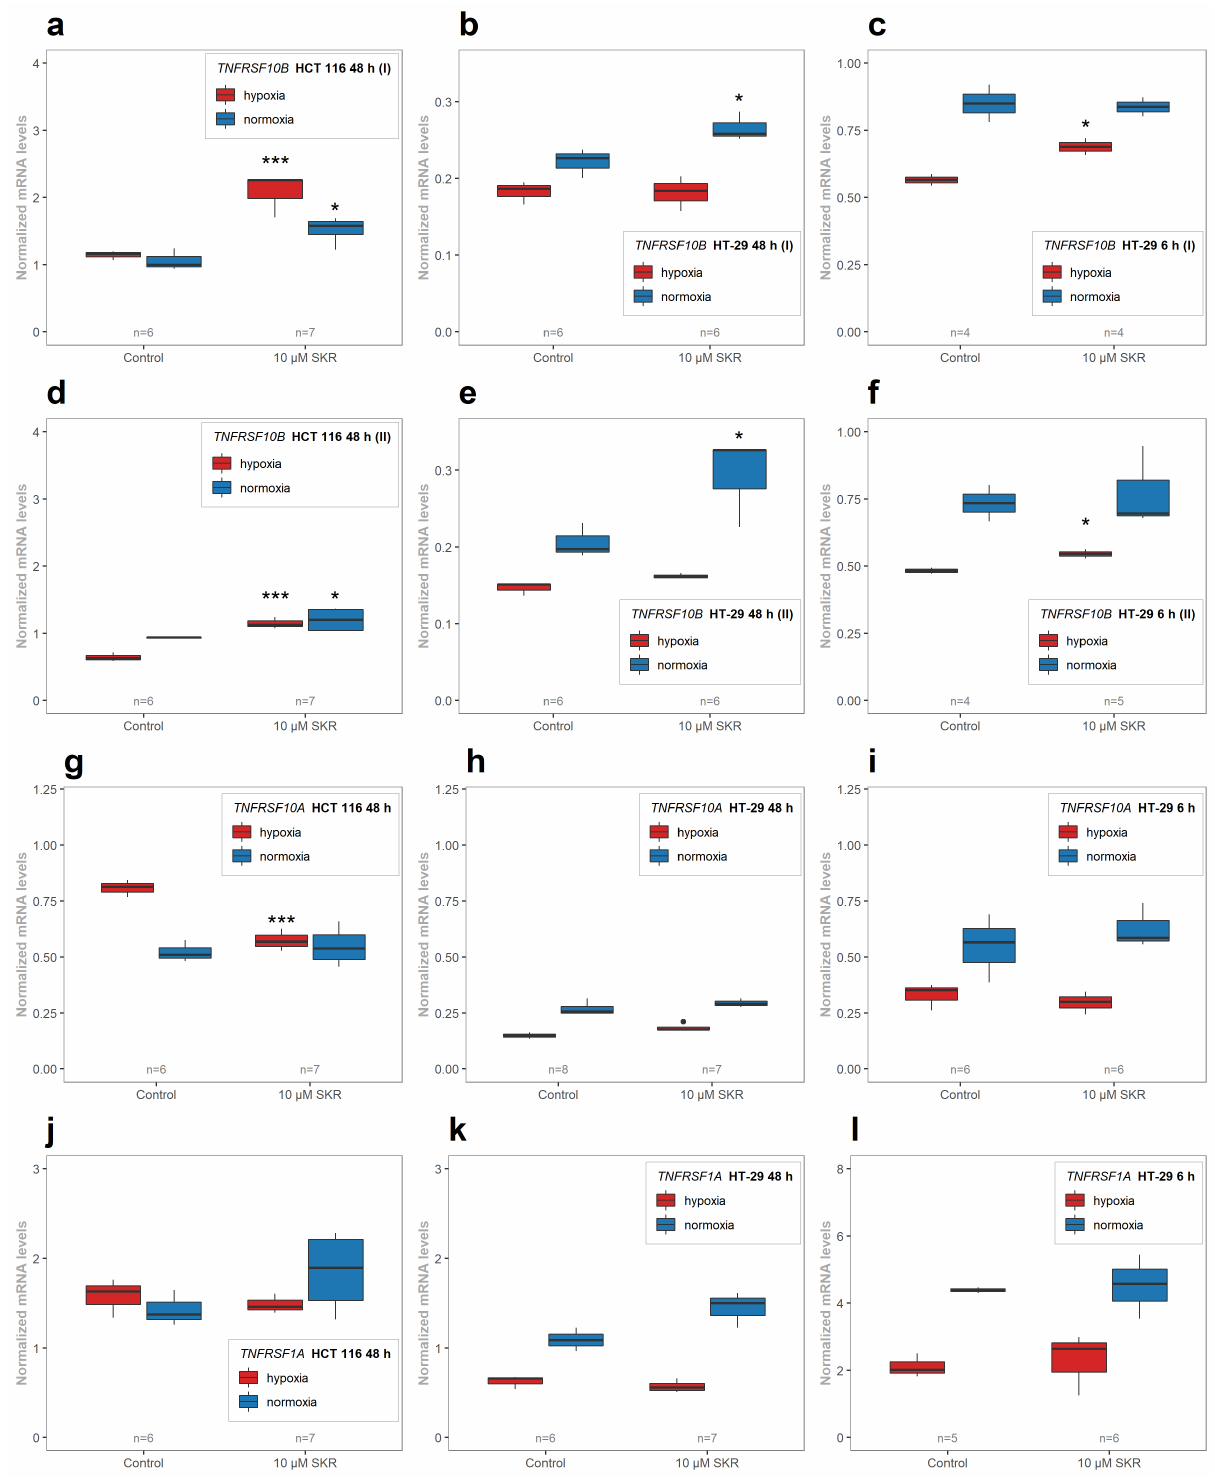
Figure 6. Normalized mRNA levels of TNFRSF10B (DR5), TNFRSF10A (DR4) and TNFRSF1A (TNFR1). Normalized mRNA levels of TNFRSF10B (DR5) of isoform 1 ( a – c ), isoform 2 ( d – f ) after SKR treatment. Normalized mRNA levels of TNFRSF10A (DR4) ( g – i ) and TNFRSF1A (TNFR1) ( j – l ). Normalized mRNA levels were evaluated by RT-qPCR and normalized to the level of reference gene PMM1 . The number of samples (n) is noted in plots. The experimental groups were compared with the matching control group (* p < 0.05, *** p <